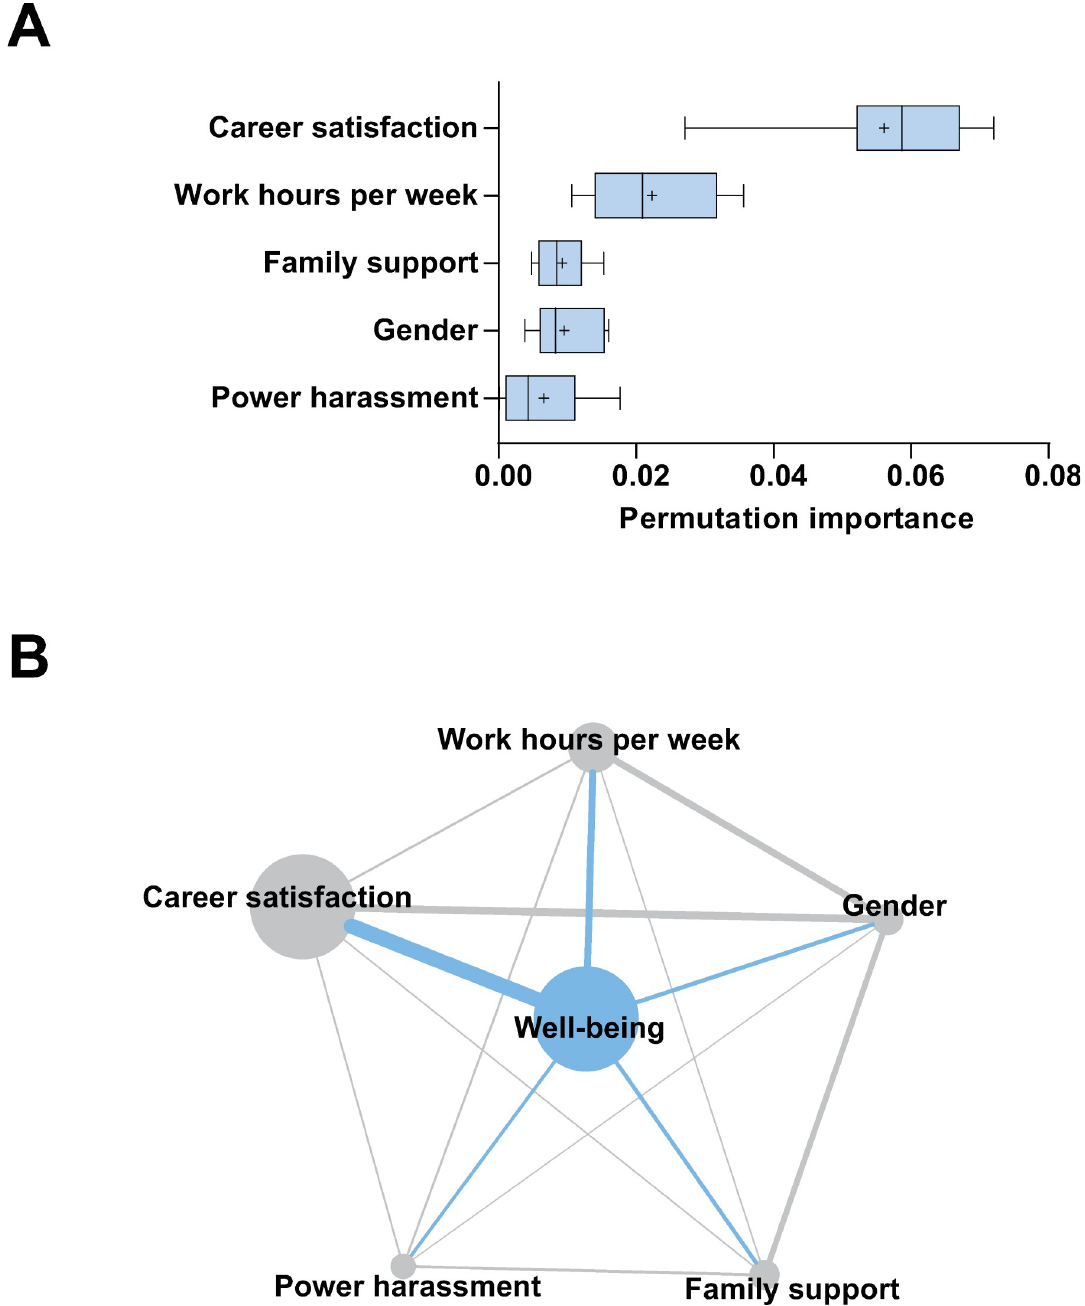
Fig 1. Variable impact on physician well-being. ( A ) Permutation importance on physician well-being was calculated for selected covariates: career satisfaction, work hours per week, family support, gender, and power harassment. Boxplots represents median, interquartile range, and extreme values. + indicates mean value. ( B ) Network between factors associated with well-being. The network between well-being and each variable is depicted in blue; the edge width and node size is determined according to the permutation importance of each variable. The network between variables is depicted in gray; the edge width is determined based on the mutual information between the two variables.